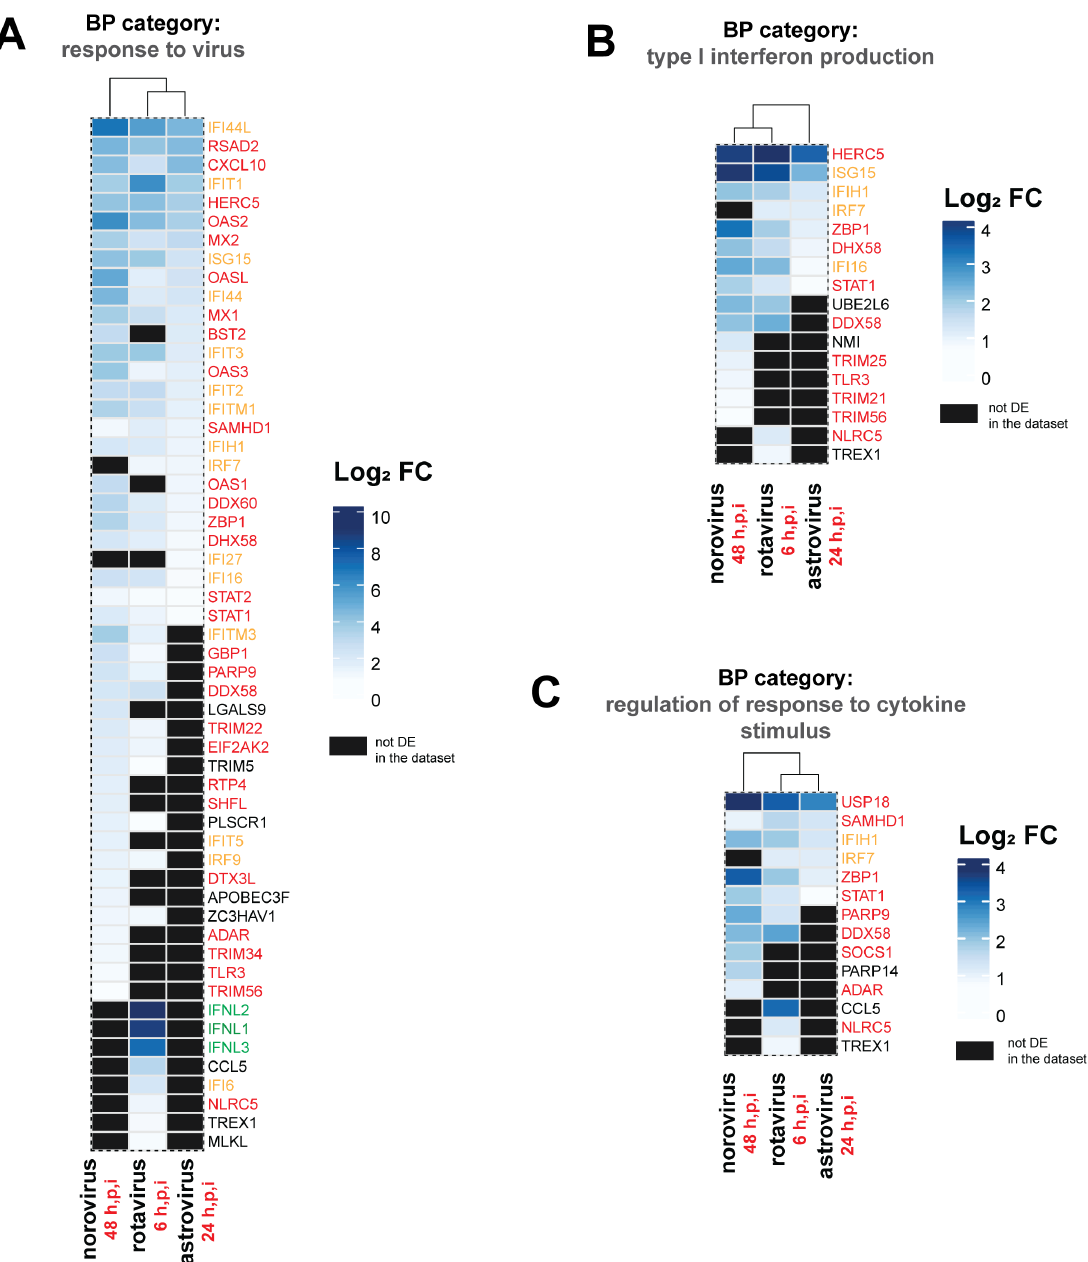
Figure 6. DEG expression patterns in shared over-represented biological processes (BP) in the three RNA-seq datasets after gene ontology (GO) over-representation analysis. Heatmap-like functional classification displays in which differentially expressed genes (DEGs) were assigned to the BP categories “response to virus” ( A ), “type I interferon production” ( B ) and “regulation of response to cytokine stimulus” ( C ). For each dataset, genes that were not differentially expressed for the indicated RNA-seq dataset are indicated in grey. Genes annotated in the Entrez Molecular Sequence Database System as part of IFN responses are highlighted in red. Genes with a symbol containing IFI (IFN-inducible) or ISG (IFN-stimulated genes) are in orange, while genes coding for IFN proteins are in green. Log 2 fold-change (FC) values within the range of each dataset are shown. Over-represented BP categories were identified with the package clusterProfiler and heatmaps generated with the package ComplexHeatmap in R. The sampling time point in hours post-infection (h.p.i) at which each RNA-seq dataset was generated is indicated.